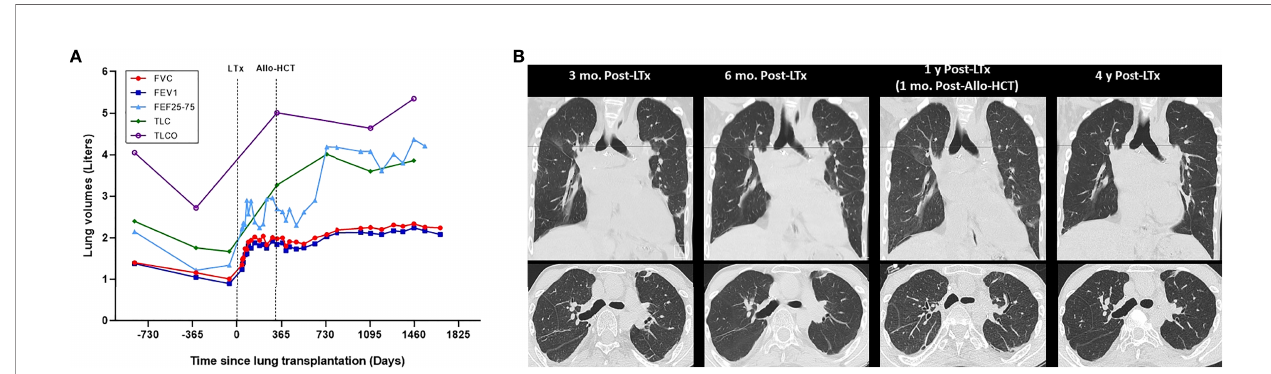
FIGURE 3 | Evolution of pulmonary function and chest CT over time. (A) Pulmonary function. (B) Chest CT. Evolution of pulmonary function over time in relation to lung transplantation (LTx) and allogeneic hematopoietic stem cell (Allo-HCT) for hereditary pulmonary alveolar proteinosis (A) , which are indicated by dotted lines. Dots represent individual measurements of lung volumes (Liters), with connecting lines between measurements showing the trend of individual lung function parameters over time. Evolution of chest computed tomography (CT) function over time (B) , with representative inspiratory phase images at 3 months, 6 months 1 year and 4 years post-lung transplantation (LTx). Allogeneic hematopoietic stem cell (Allo-HCT) was performed 11 months after prior lung transplantation. At 4.5 years after lung transplantation there is currently no evidence for chronic lung allograft dysfunction, graft-versus-host disease, or recurrence of hereditary pulmonary alveolar proteinosis. FVC, forced vital capacity; FEV1, forced expiratory volume in one second; FEF25-75, forced expiratory fl ow at 25 – 75% of forced vital capacity; TLC, total lung capacity; TLCO, transfer capacity of the lung, for the uptake of carbon monoxide (CO) (also called diffusing capacity for carbon